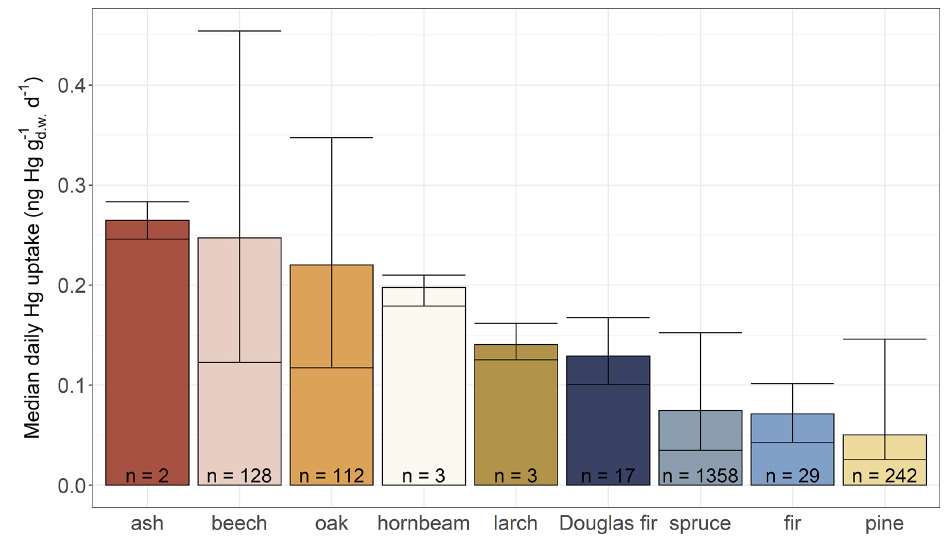
Figure 3. Median daily foliar Hg uptake (ngHgg − 1 d − 1 ) between different tree species groups (see Table S1 for definition of tree species d.w. groups) arranged from highest to lowest value. Error bars give the value range within each tree species group, and n indicates the number of sites at which the respective tree species were sampled in both the years 2015 and 2017. Foliar samples of evergreen coniferous tree species (Douglas fir, spruce, fir and pine) consist of needles of the current